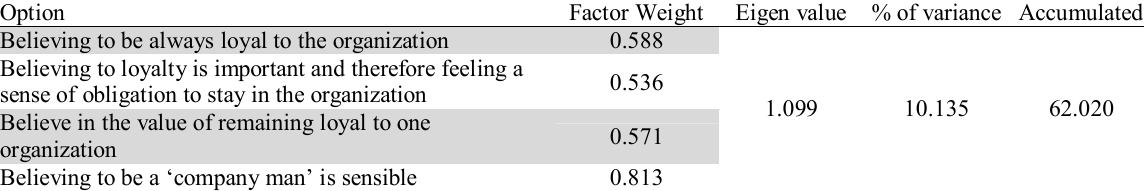
Details of factor analysis for Enduring commitment in Organizational commitment Option Factor